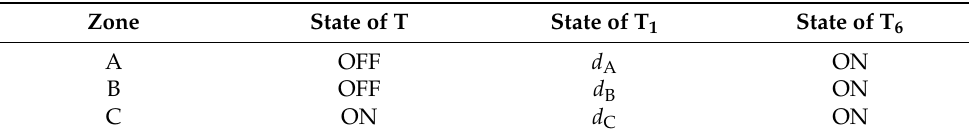
Table 1. The state of DC-link switch T and inverter switch T 1 , T 6 during the “a + b − ” normal conduction